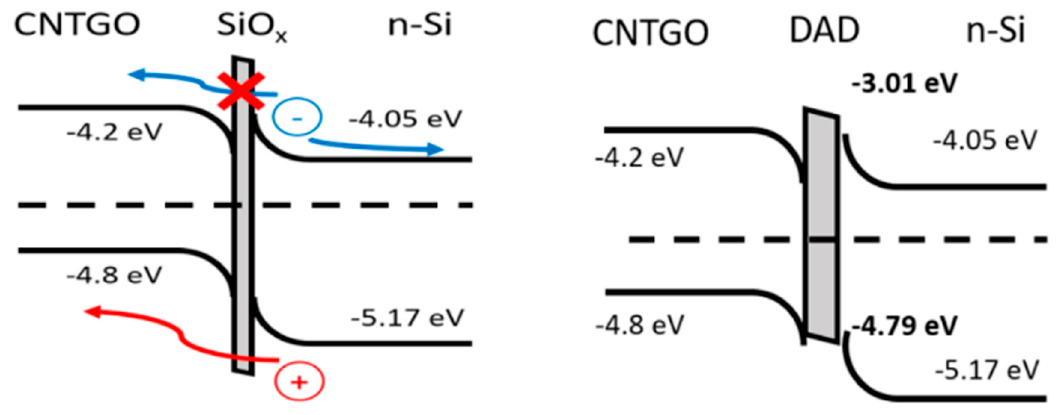
Figure 6. Energy diagrams for CNT / Si heterojunction solar devices with and without a DAD interlayer.